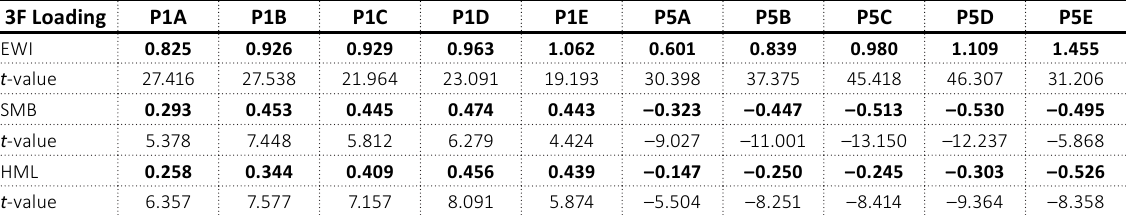
Table 10. Regression coefficient analysis of three-factor (Fama-French) alpha of portfolios independently sorted on size and volatility with their corresponding t